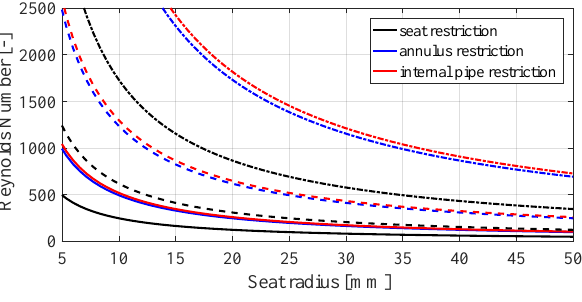
Figure 3: Analytical calculated Reynolds number at 100 ( full line ), 250 ( dashed lines ) and 700 ( dot-dashed lines ) L/min as a function of seat